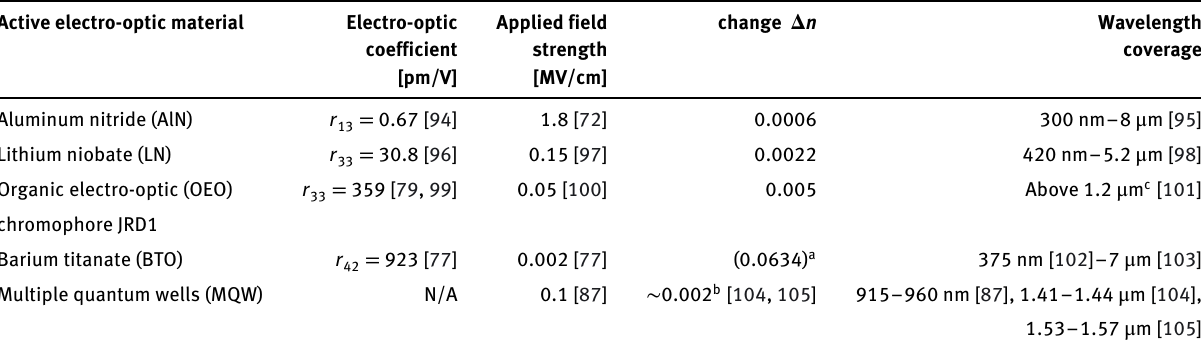
Table 1: Refractive index change Δ n obtained through experimentally reported values of the electro-optic coefficient and the applied field strength for a variety of thin-film electro-optic materials and multiple quantum wells integrated into nanophotonic devices. The wavelength coverage corresponds to the transparency window of different electro-optic